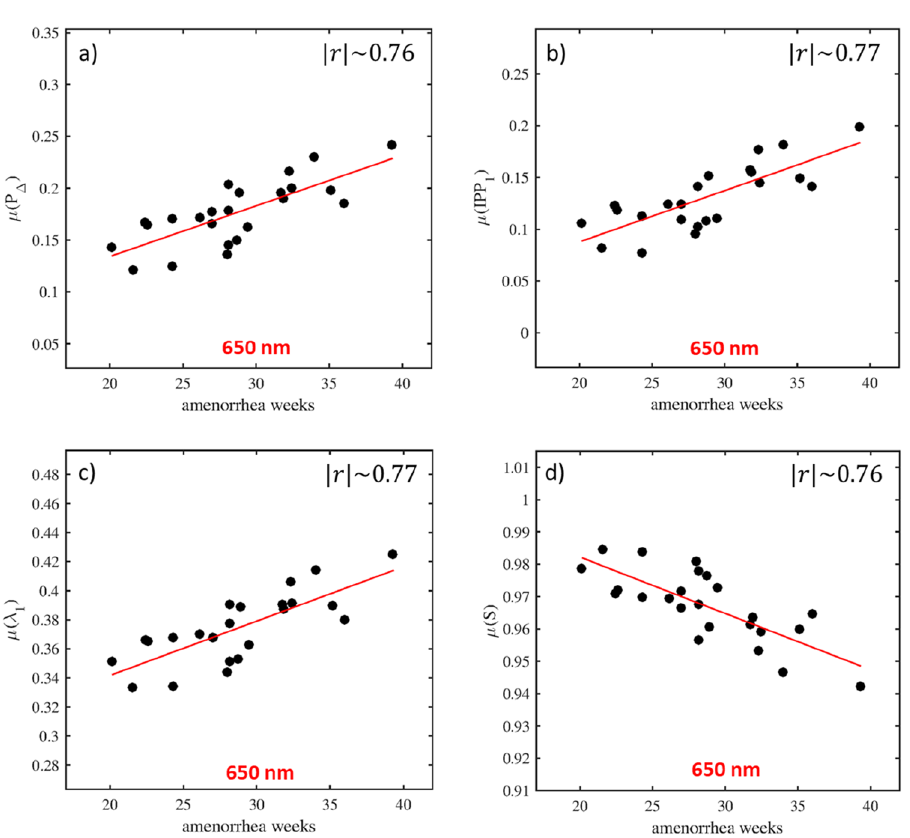
Figure 5. (a – d ) Evolution curves describing the modification of µ ( P � ) , µ ( IPP 1 ) , µ ( (cid:31) 1 ) , and µ ( S ) at 650 nm according to the gestational age, respectively. These parameters have a high correlation with the gestational age, | r | varying between 0.76 and 0.77